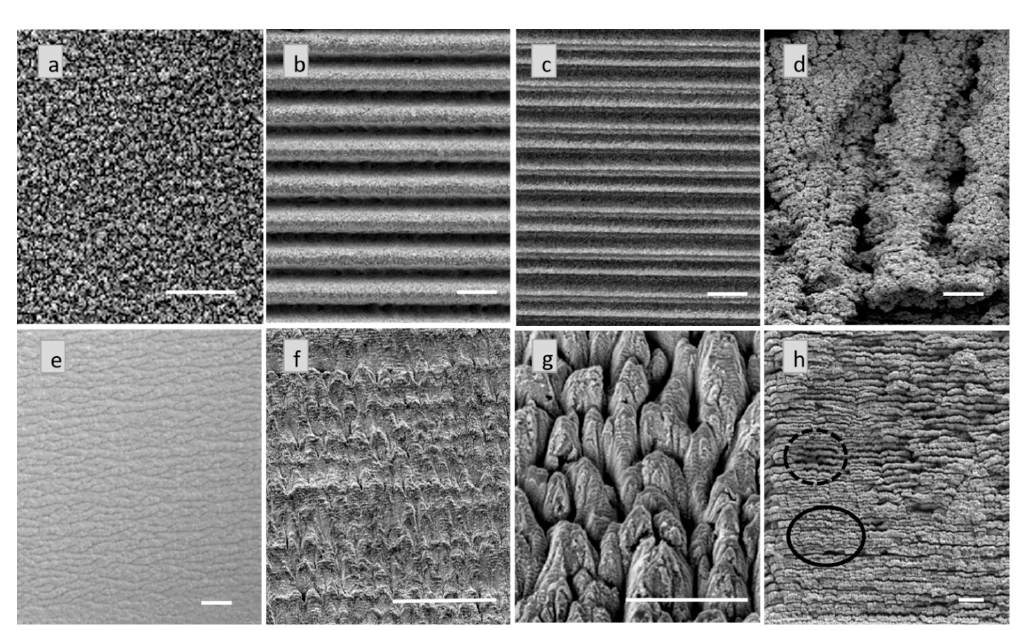
Figure 1. Representative images of the microstructures on Cu machined at 1 kHz ( a ) Nanoforest; ( b ) Deep and well defined trenches; ( c ) Narrow trenches; ( d ) Rough and rugged chaotic structures; ( e ) Tree bark; ( f ) Stalagmite structures; ( g ) Fish scales and ( h ) Aggregate structures showing the partial breaking (solid circle) of the top layer and the underlying structure (dashed circle). All scale bars represent 50 µm.